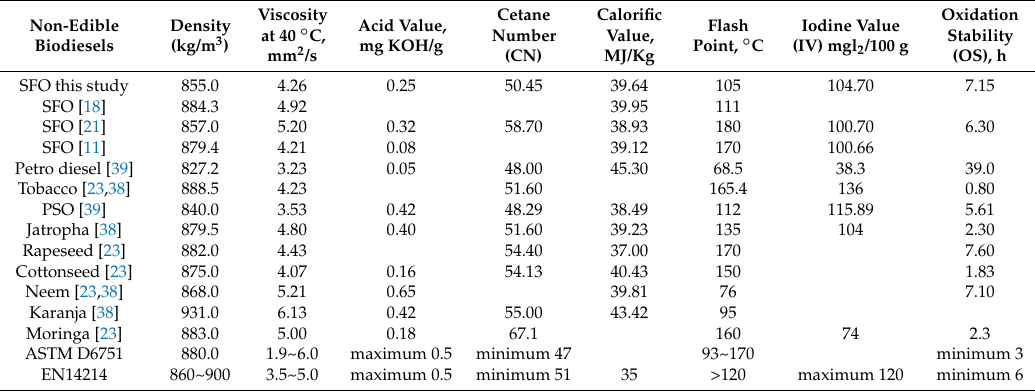
Table 3. Comparison of SFO biodiesel with other non-edible biodiesels.